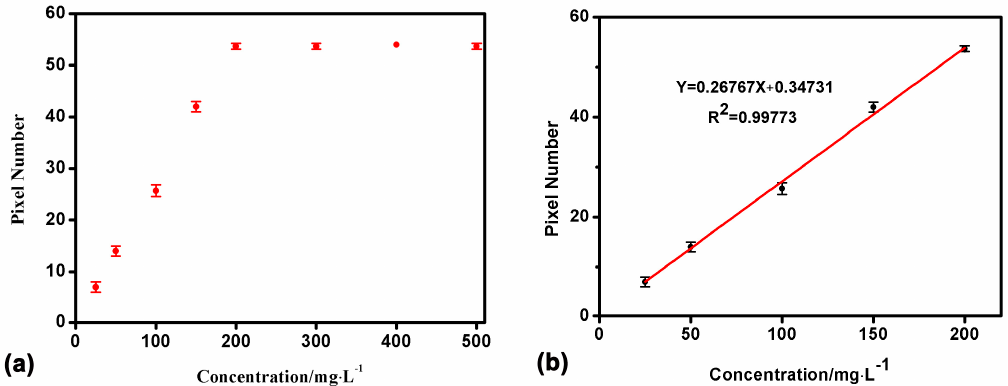
Figure 5. Detection results of the IgG immunological reaction. ( a ) Shift of the pixel increment for different concentrations of anti-IgG; ( b ) Below the saturation concentration (25–200 mg/L), the interrelationship between the concentration and response is linear R 2 = 0.99773 (repeat times n = 3).